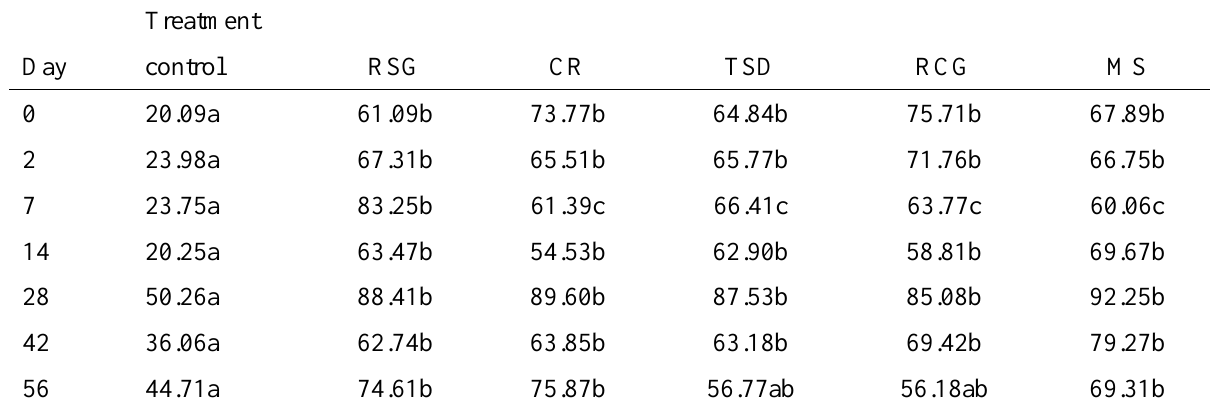
Table 2. Mean inorganic-N (g kg -1 ) at different times during the incubation. Control = soil without amendments, RSG = soil fertilised with anaerobically digested reed sweet-grass, CR = soil fertilised with common reed digestate, TSD = soil fertilised with tufted sedge digestate, RCG = soil fertilised with reed canary grass digestate, MS = soil fertilised with maize digestate. Different appended letters indicate significant differences among treatments (p < 0.05) according to Tukey’s test.